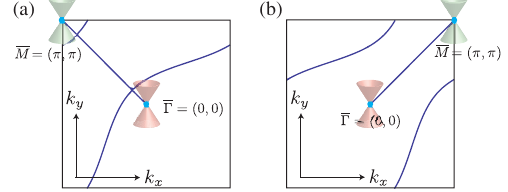
FIG. 13. Fermi arcs (blue lines) on the (001) surface with alternative boundary conditions (a) g ð k